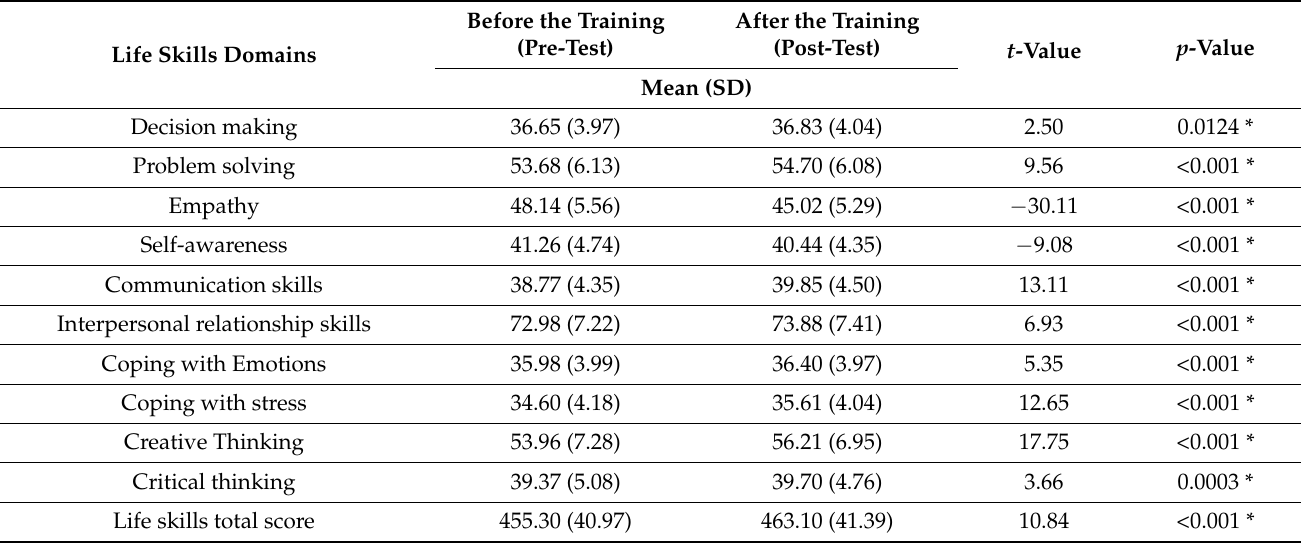
Table 3. Pre- and post-score assessment of life skill domains among participants of the LSTCSP ( n = 2669).